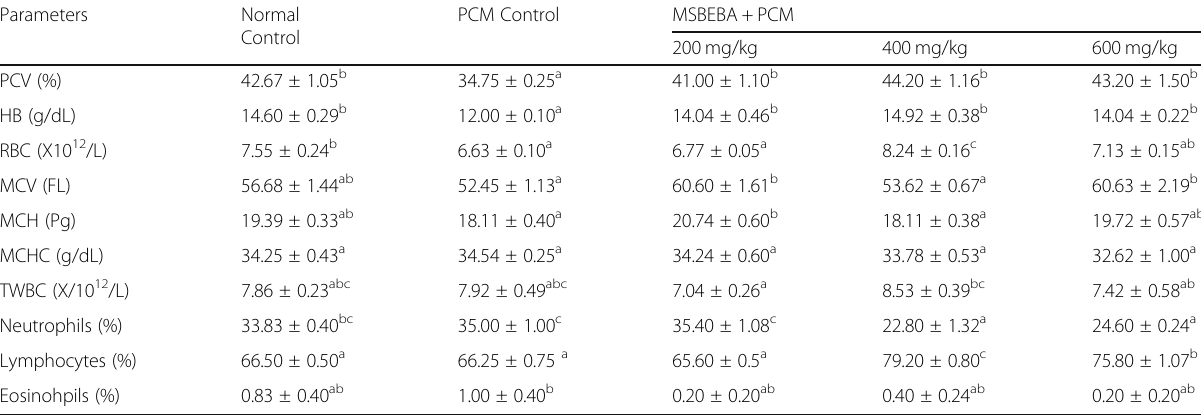
Table 1 Haematological parameters of acetaminophen-poisoned rats treated with MSBEBA